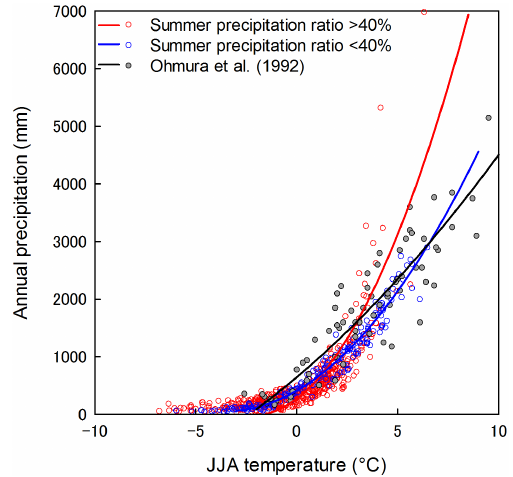
Figure 10. Relation between mean summer (JJA) air temperature and annual precipitation at L-average elevation. Red and blue circles indicate summer-accumulation-type and winter-accumulation-type glaciers, respectively. Grey circles indicate the data set reported by Ohmura et al. (1992).